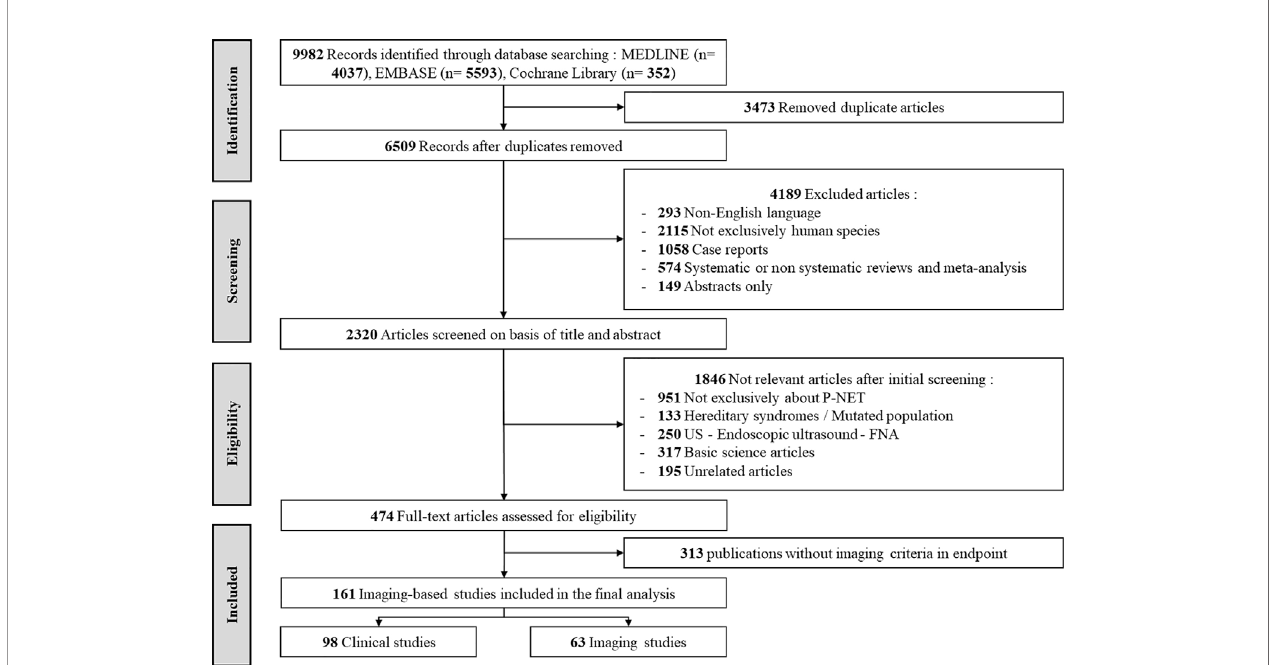
FIGURE 1 | PRISMA fl ow chart of literature search and study selection